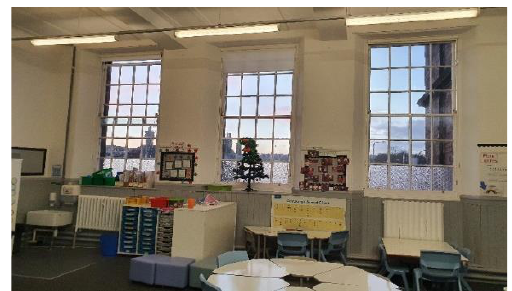
Figure 14. Picture of classroom D1.